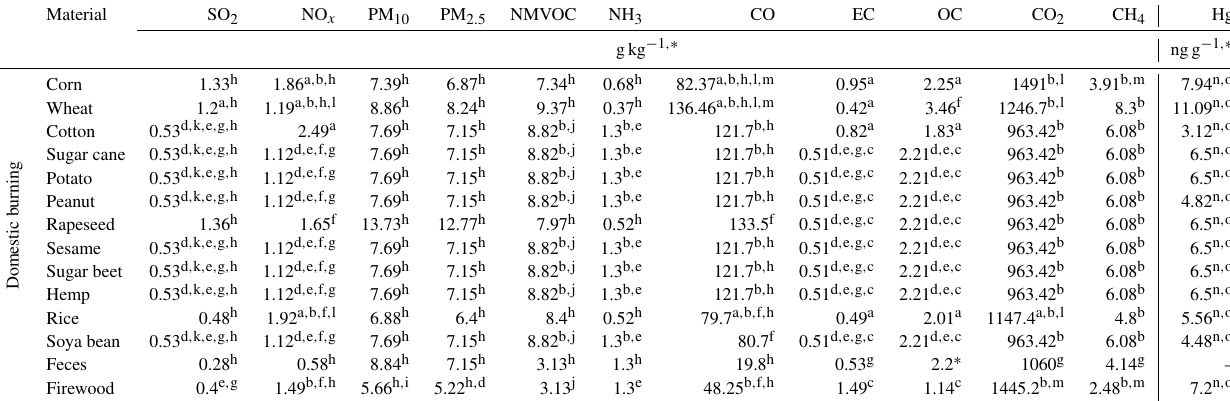
Table 5. Emission factors used in the estimation of domestic biomass burning emissions. Material